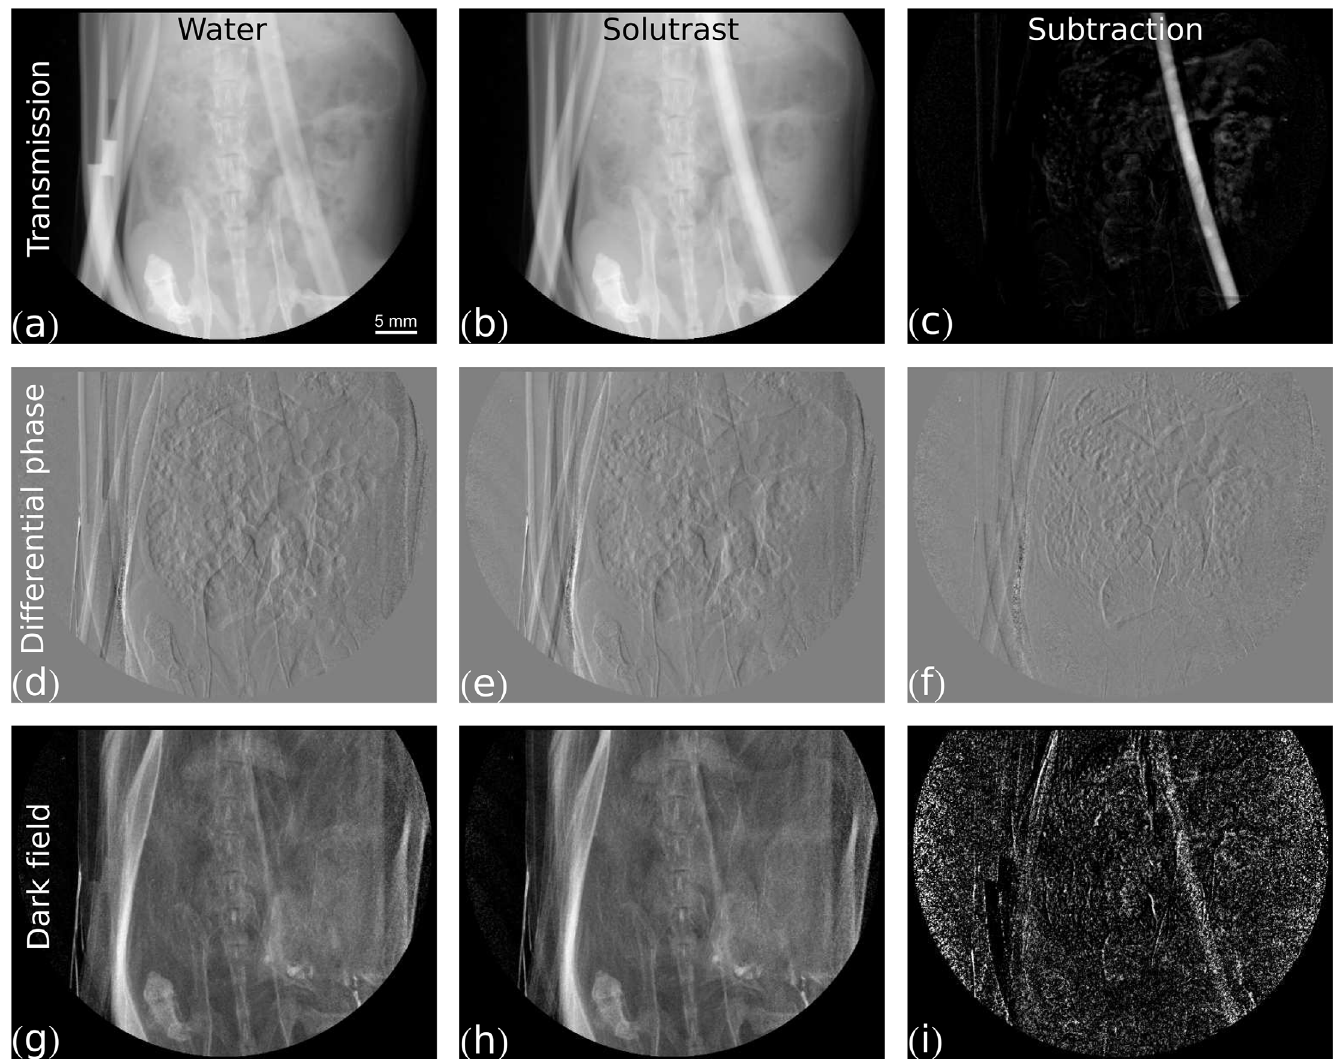
Fig 2. Measurement of pure Solutrast contrast agent. Grey value scaling is given in brackets. The first column shows the same image with the tube filled with water for three different contrast modalities: (a) transmission [0, 0.9], (d) differential phase [ (cid:1) p same image with the tube fi lled with pure Solutrast in three different modalities: (b) transmission [0, 0.9], (e) differential phase [ (cid:1) p The third column shows the subtraction of the image with contrast agent (second column) from the image with water ( fi rst column) for three different contrast modalities: (c) transmission [0, 0.2], (f) differential phase [ (cid:1) p